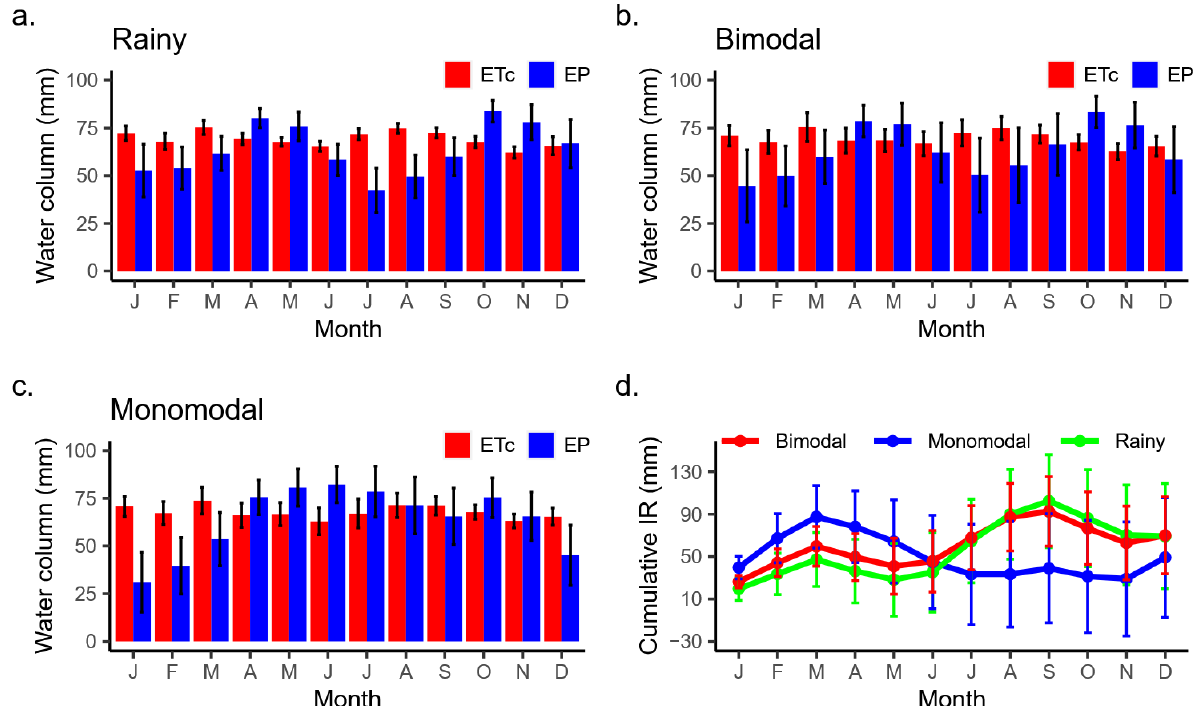
Figure 4. Average annual distribution of EP (effective precipitation), ET c (crop evapotranspiration) at PPA (potential production area in Colombia) in: ( a ) rainy; ( b ) bimodal; and ( c ) monomodal precipitation regimes, and ( d ) the cumulative IR (irrigation requirement). Error bars correspond to absolute (panels ( a ) to ( c )) and cumulative (panel ( d )) standard deviation.